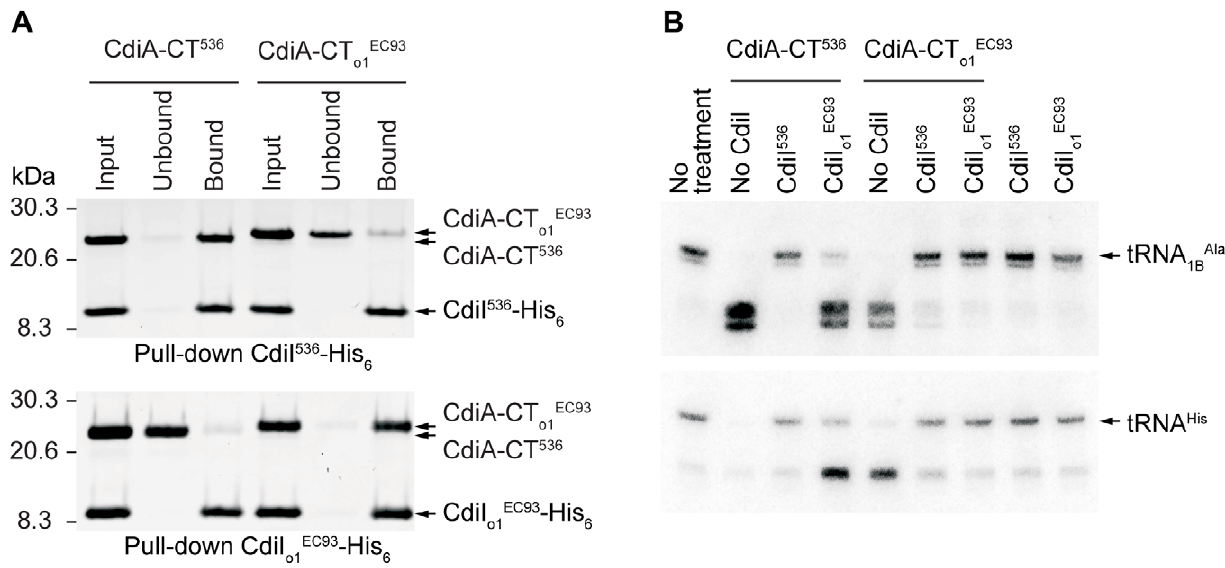
Figure 4. The tRNase activity of CdiA-CT o1EC93 is blocked by the binding of CdiI o1EC93 . A) Analysis of CdiA-CT/CdiI binding. Purified CdiA- CT and CdiI-His 6 proteins were mixed at equimolar ratios then purified by Ni 2 + -affinity chromatography. Input samples represent the protein mixtures prior to chromatography. Unbound fractions contain proteins that failed to bind the affinity resin. Bound proteins were eluted from the affinity resin with imidazole. All fractions were analyzed by SDS-PAGE. B) Northern blot analysis of CdiA-CT UPEC536 and CdiA-CT o1EC93 tRNase activity. S100 fractions containing cellular tRNA was treated with purified CdiA-CT and/or CdiI-His 6 proteins and then analyzed by Northern blot hybridization using probes specific for tRNA 1BAla and tRNA His .